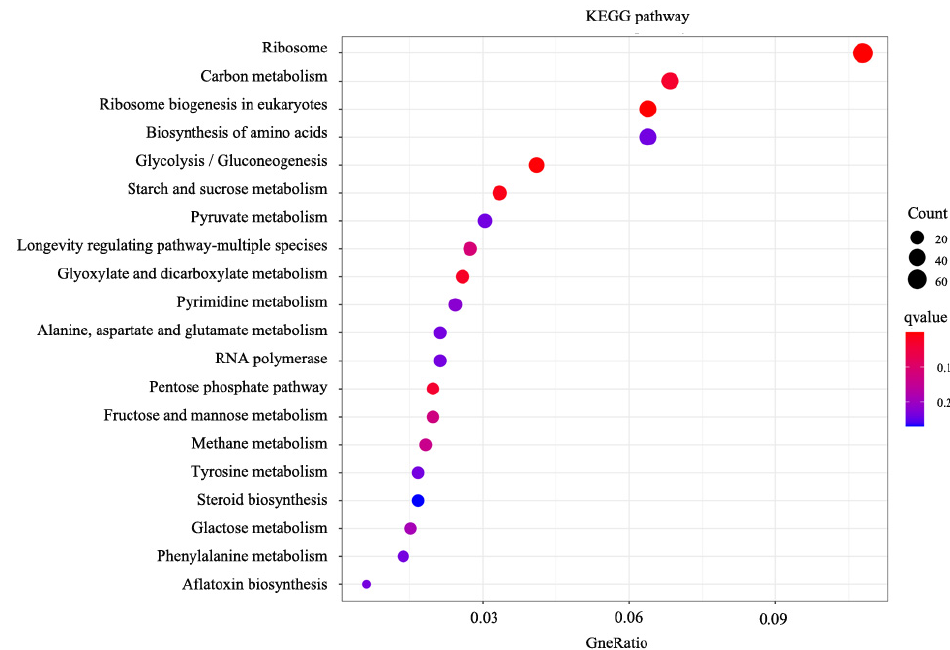
Figure 5. Enrichment scatter diagram of KEGG pathways.